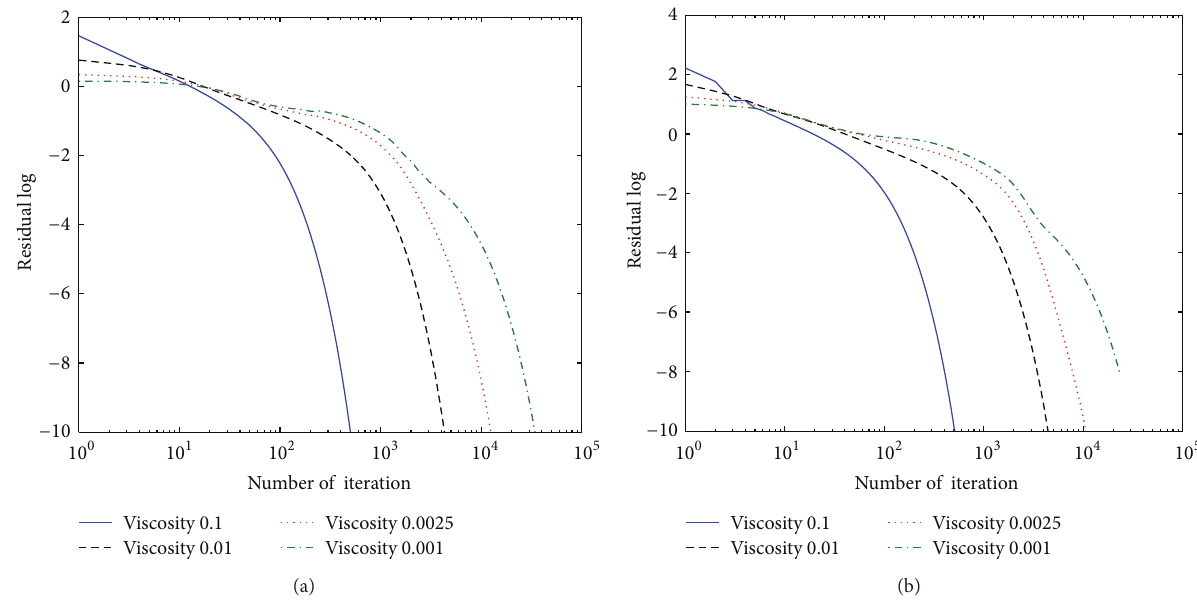
Figure 3: Solver convergence (log-log scale) for different values of mean viscosity with 𝑃 = 2 and 𝑀 = 2 , cavity 500, (a) and cavity 1900 (b).